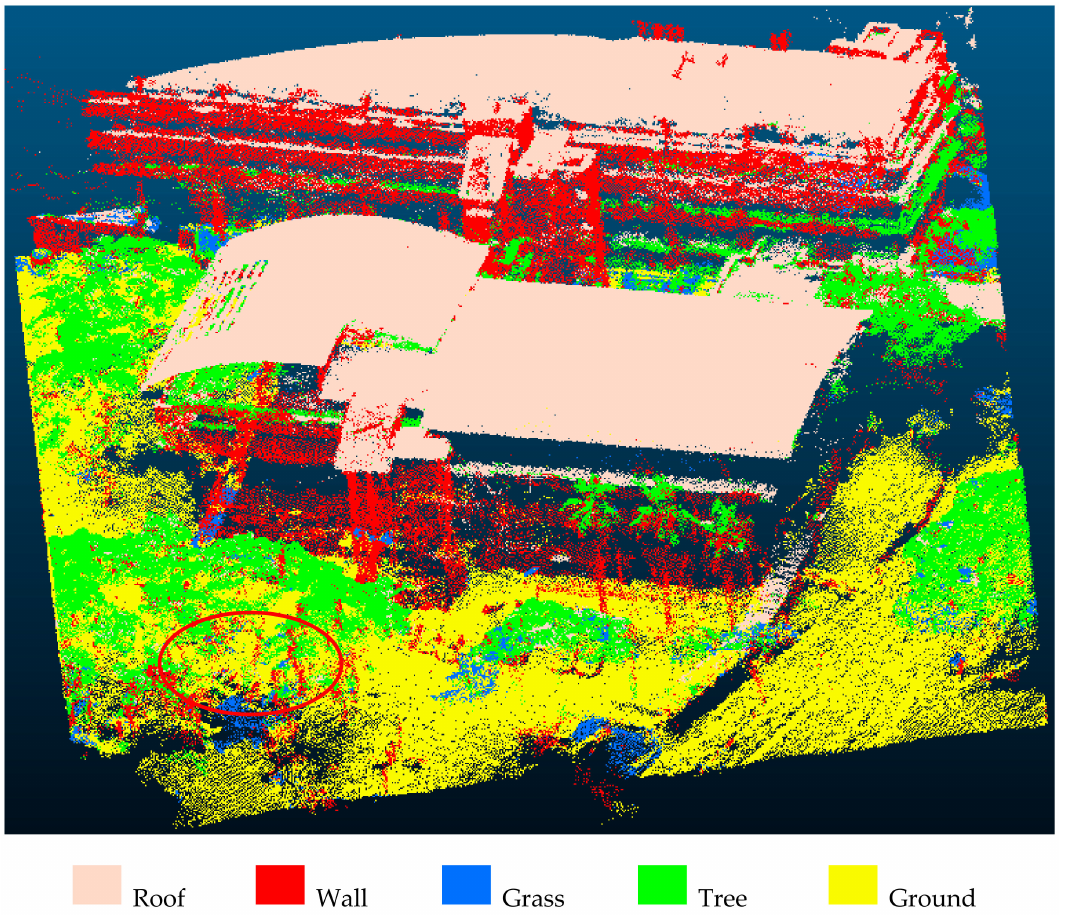
Figure 12. Results of point-based classification of